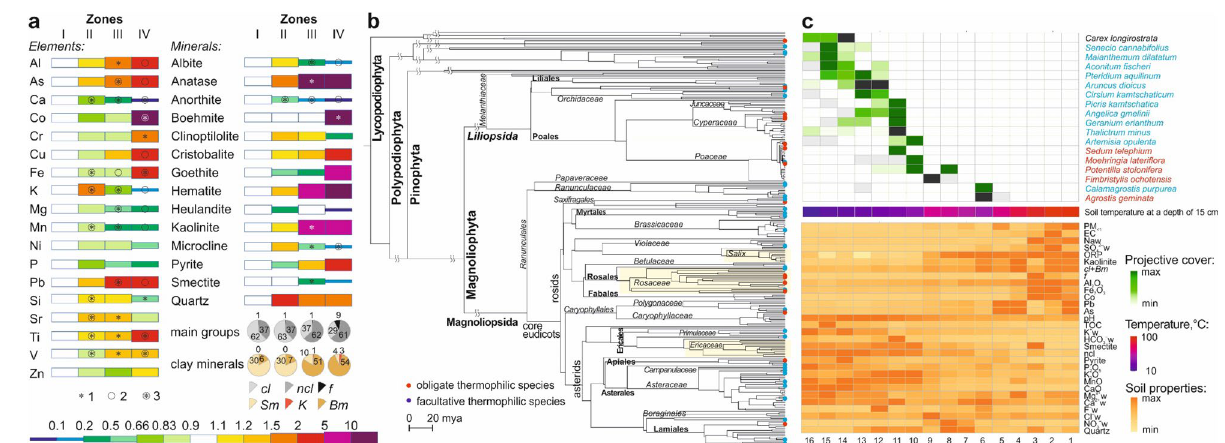
Figure 4. Partition of the topsoil (0–10 cm) and plants in different thermal zones of catena studied: ( a ) Element and mineral composition. Significant ( p < 0.05) differences between composition of soils: 1—adjacent zones (I and II, II and III or III and IV), 2—zone I and other zones (II, III and IV), 3—in the zone under consideration and composition of soils both in zone I and in a cooler adjacent zone. The concentration of chemical elements and minerals are normalized to the composition in soils of zone I: depletion—blue and green, accumulation— yellow and red. Main groups of minerals (100%): cl— clay minerals (kaolinite, smectite, boehmite), ncl —non- clay minerals (microcline, albite, anorthite, clinoptilolite, heulandite, anatase, quartz, cristobalite), f— minerals of iron (pyrite, hematite, goethite, jarosite, marcasite). Clay minerals (100%): Sm —smectite, K —kaolinite, Bm — boehmite. ( b ) The thermophilic species observed along the catena on the phylogenetic tree of all the vascular plants occurred in the Valley of Geysers. ( c ) The key factors limiting plant species (black, non-thermal species; blue, facultative thermophytes; red, obligate thermophytes) growth within 1 × 1 m plots at the catena studied. 1–16, numbers of